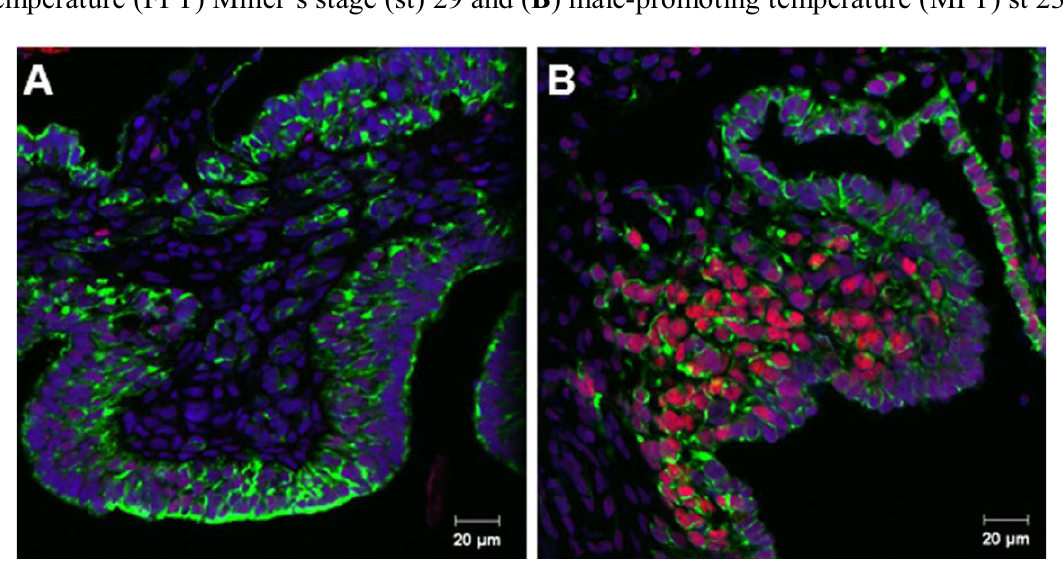
Figure 1. Double immunofluorescence of SOX9 (red) and cytokeratin (green) in gonads from L. olivacea in ovo. ( A ) Gonads of embryos incubated at female-promoting (cid:87)(cid:72)(cid:80)(cid:83)(cid:72)(cid:85)(cid:68)(cid:87)(cid:88)(cid:85)(cid:72)(cid:3)(cid:11)(cid:41)(cid:51)(cid:55)(cid:12)(cid:3)(cid:48)(cid:76)(cid:79)(cid:79)(cid:72)(cid:85)(cid:182)(cid:86)(cid:3)(cid:86)(cid:87)(cid:68)(cid:74)(cid:72)(cid:3)(cid:11)(cid:86)(cid:87)(cid:12)(cid:3) 29 and ( B ) male-promoting temperature (MPT) st